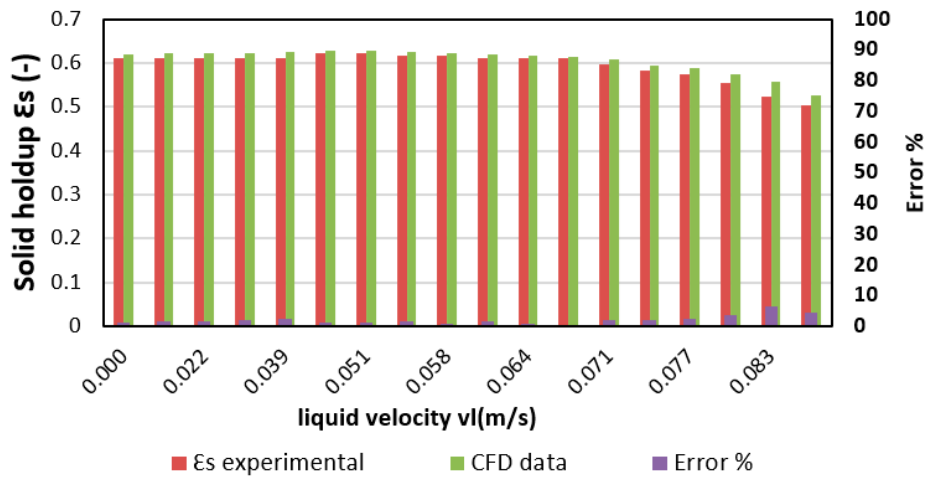
Figure 13. Comparisons between CFD simulation results and experimental data of solid holdup for particles with a diameter of 6 mm for different superficial liquid velocities.